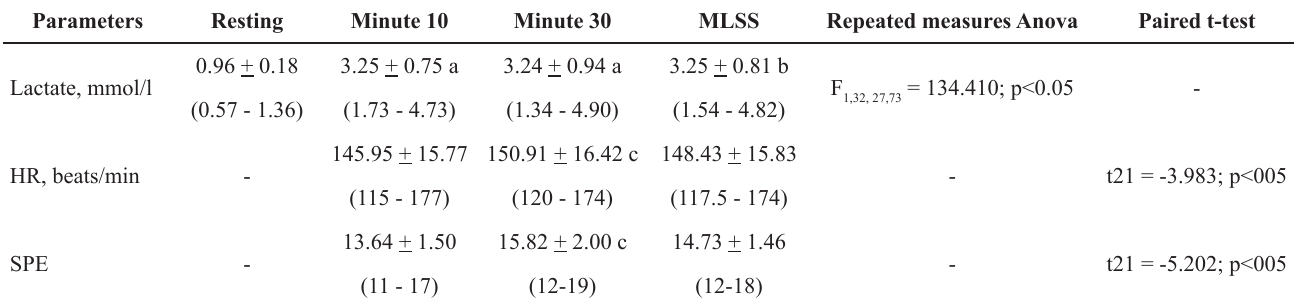
Table 2. Values of the maximal lactate steady state test Parameters Resting Minute 10 Minute 30 MLSS Repeated measures Anova Paired t-test Lactate, mmol/l